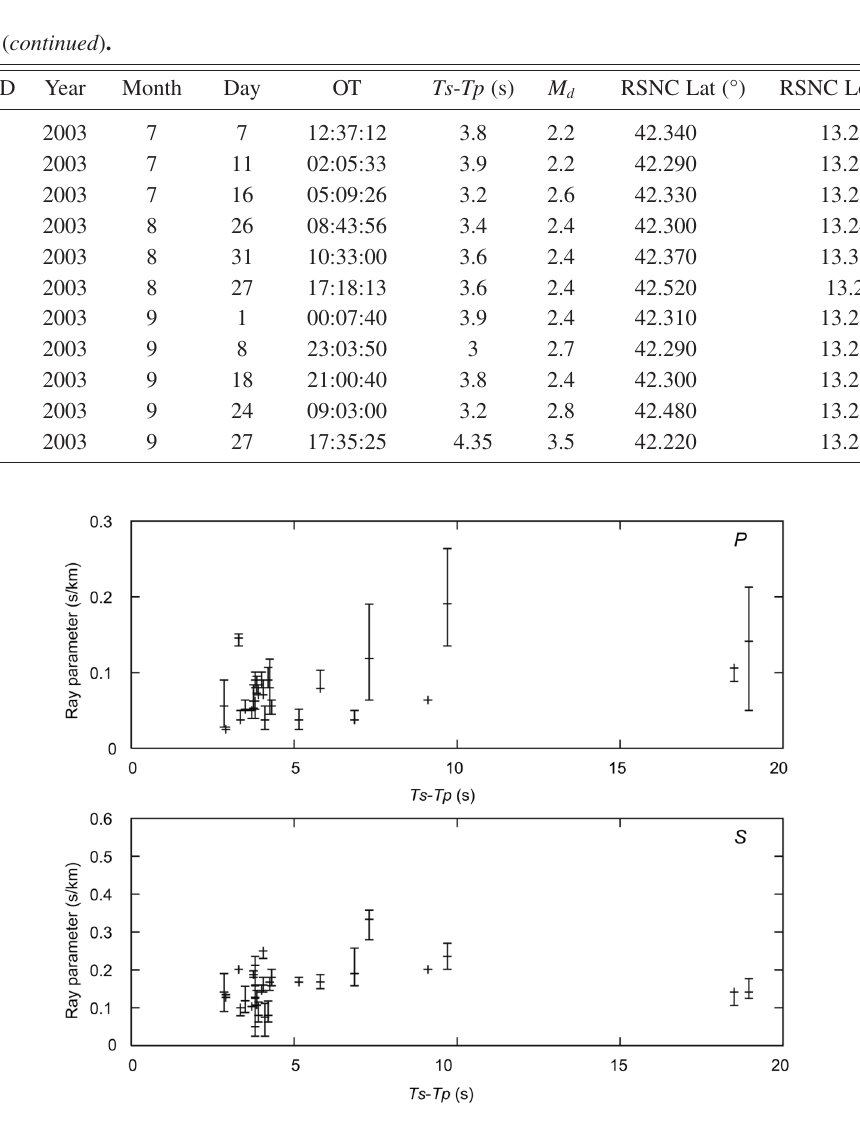
Fig. 11. P - and S -waves ray parameters as a function of S-P delay times for all the events listed in table I.